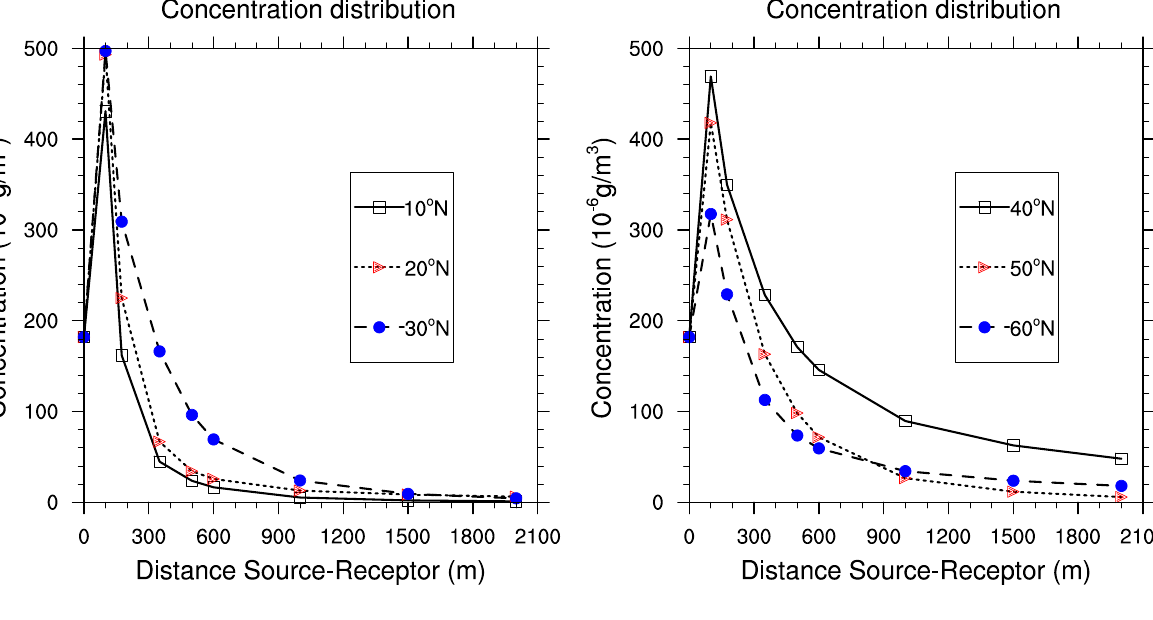
Figure 10. 5 years (43,800 h) concentration distribution in terms of the distance from source to receptor. The directions of receptors are defined according to the wind rose which extends from 10 ◦ to 360 ◦ N by step of 10 ◦